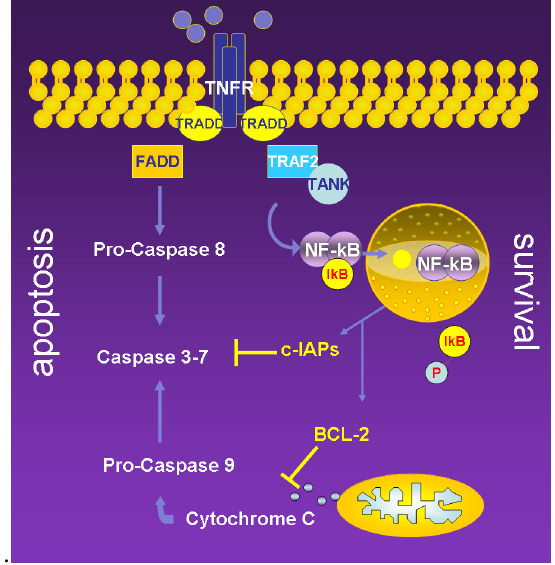
Figure 2. Schematic drawing showing the TNF-driven survival and apoptosis